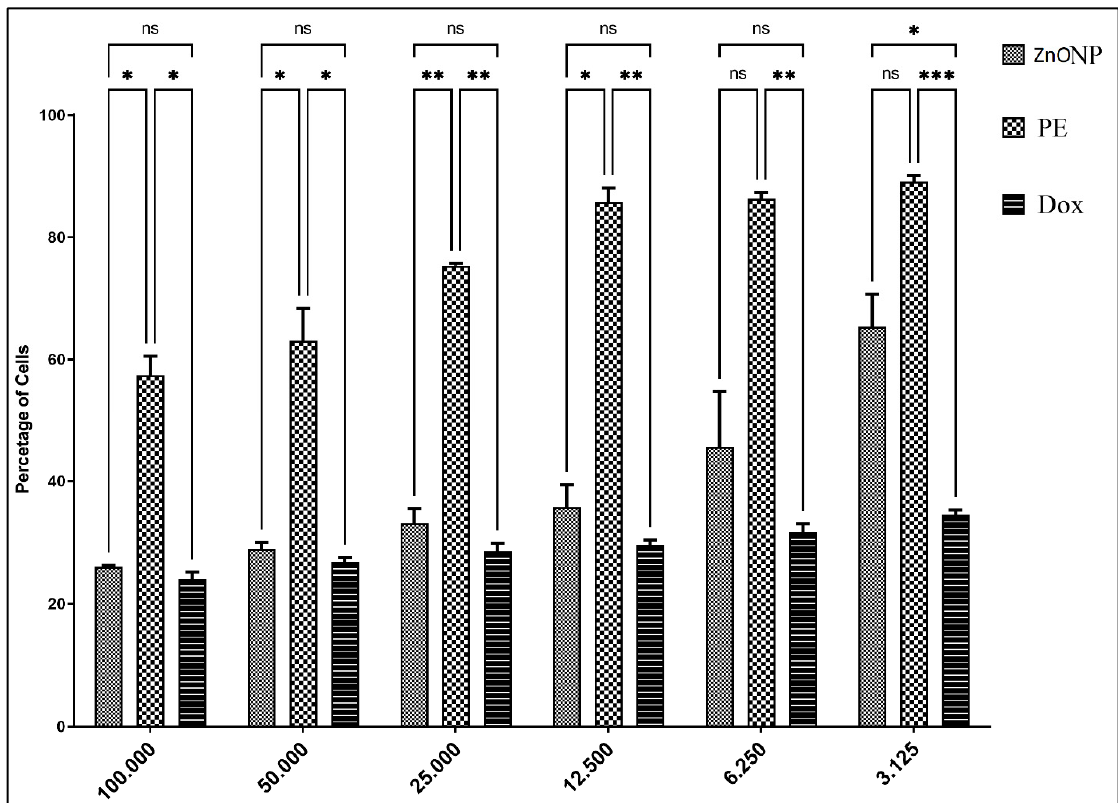
Figure 10. The Cytotoxicity PE, ZnONPs, and Doxorubicin using MTT assay. [The difference was regarded as significant when * p < 0.05 significant, ** p < 0.01 moderately significant, *** p < 0.001 highly significant].